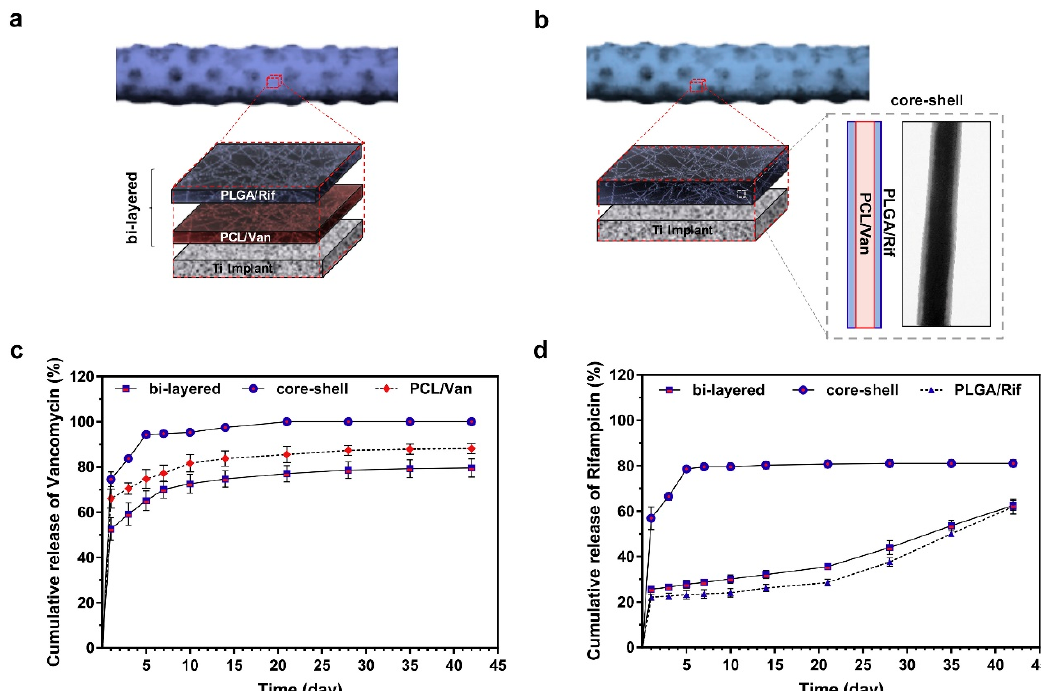
Figure 7. Various assembly and in vitro antibiotic release profiles of drug-loaded nanofiber-filled lattice implants. Reprinted with permission from ref. [142]. ( a ) The structure of the bi-layer nanofiber filled with PCL/Van as the inner layer and PLGA/Rif as the outer layer. ( b ) The structure of the core–shell nanofiber is composed of PCL/Van in the core and PLGA/Rif in the shell. The core–shell structure was verified by transmission electron microscope. Cumulative release of Van ( c ) and Rif ( d ) from three different nanofiber-filled lattice structures within 6 weeks. (Abbreviations: PCL, poly( ε -caprolactone); PLGA, poly`1q`(lactic-co glycolic acid); Van, vancomycin; Rif, rifampicin.).